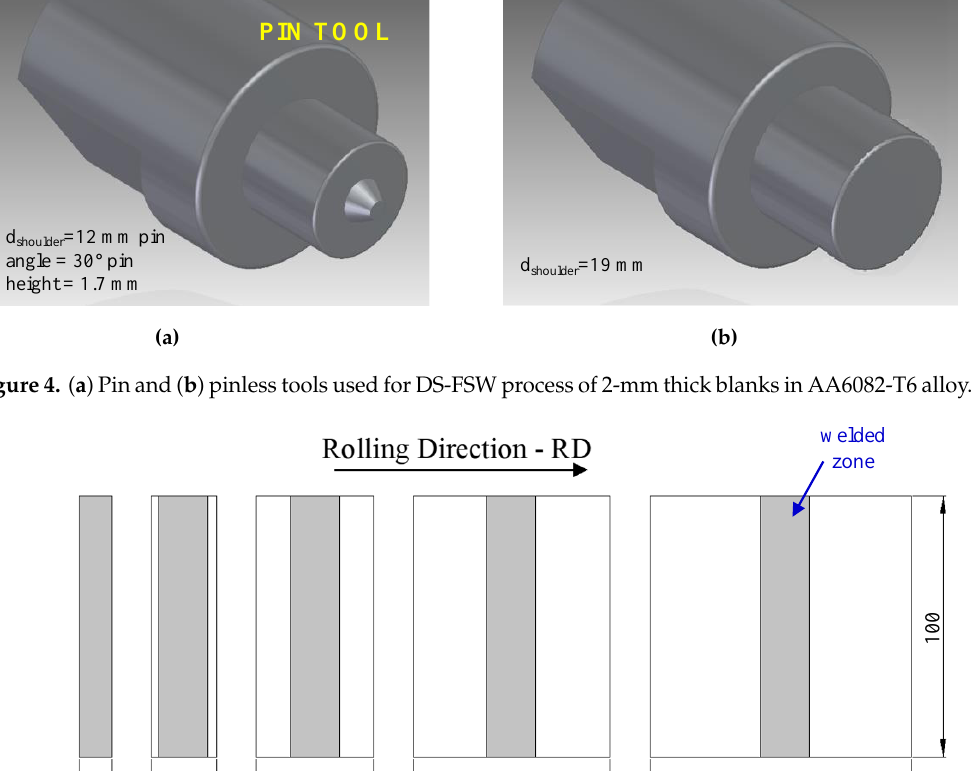
Figure 5. Welded samples used for the hemispherical punch test (data are reported in mm).